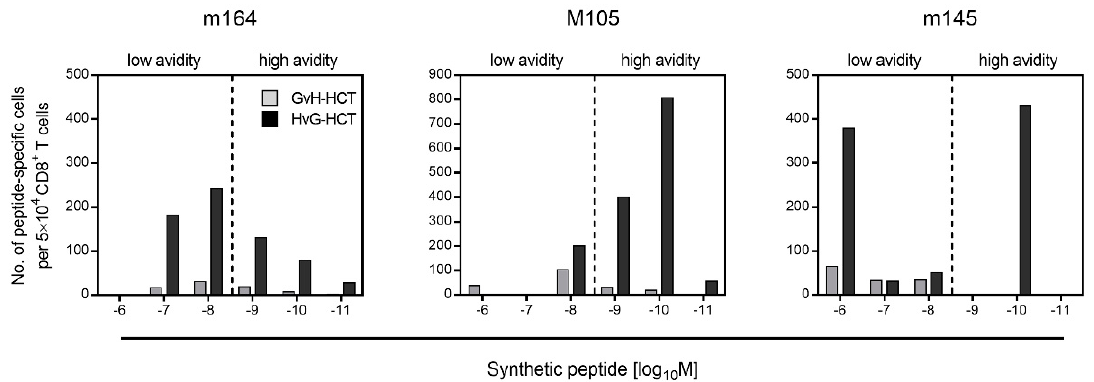
Figure 2. Frequencies and functional avidities of liver-derived, viral epitope-specific IFN γ + CD8 + T cells after GvH-HCT compared to HvG-HCT. Reproduced from reference [42] in a modified graphical presentation.